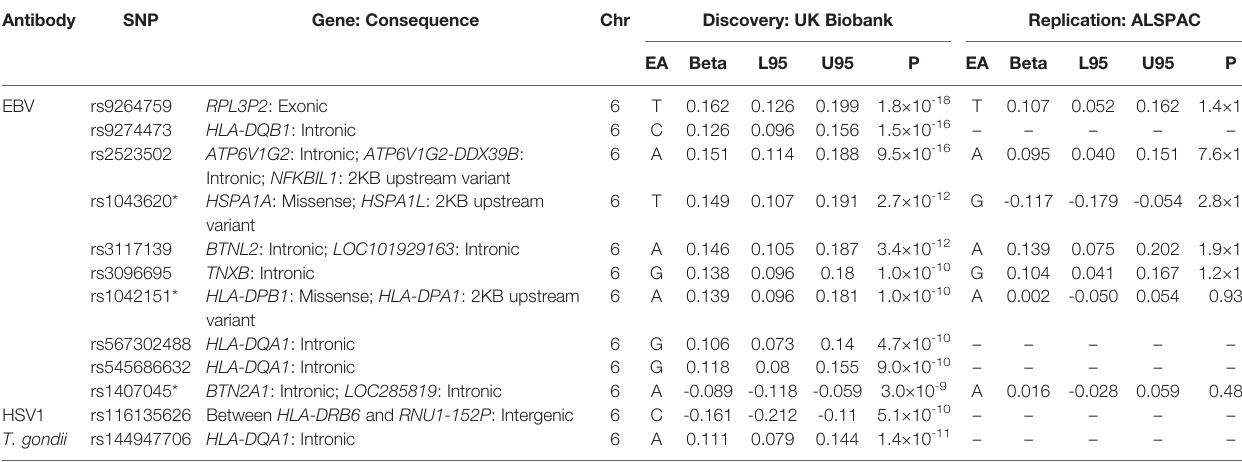
TABLE 7 | Top SNPs in discovery GWAS in UK Biobank with replication GWAS in ALSPAC seven-year clinic ( P < 0.001). Antibody